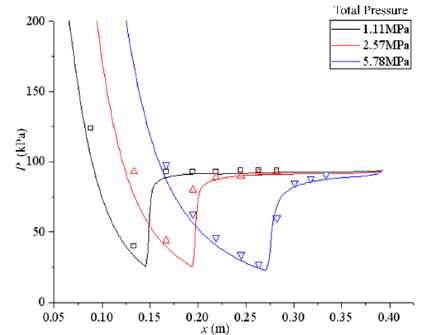
Figure 14. Numerical calculation and experiment of other inlet total pressures.